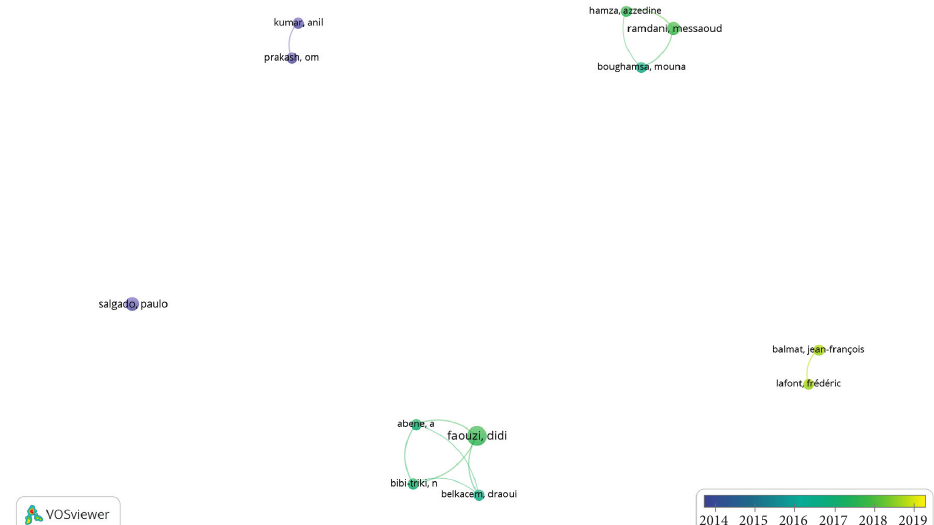
Figure 2: Co-authorship map analysis.